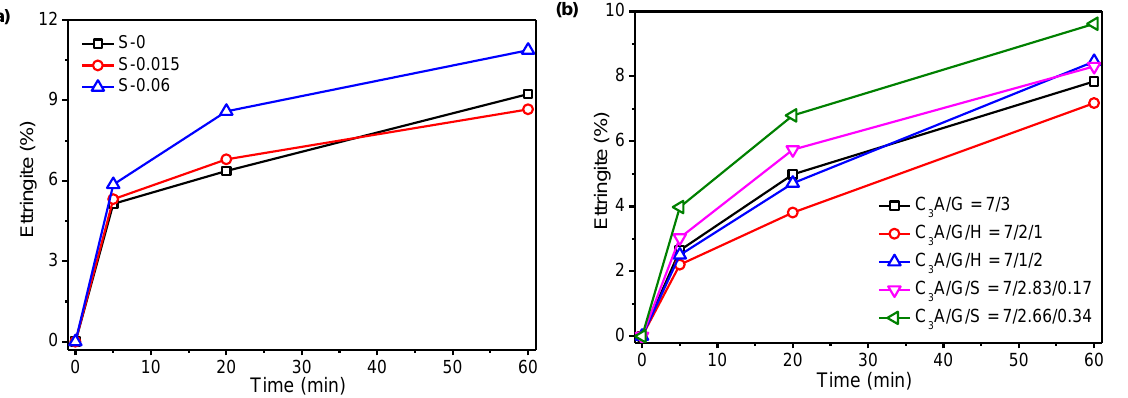
Figure 2. Amount of precipitated ettringite during the first hour: ( a ) effect of SO 4 2− concentration in simulated solution; ( b ) effect of hemihydrate and Na 2 SO 4 in solid.